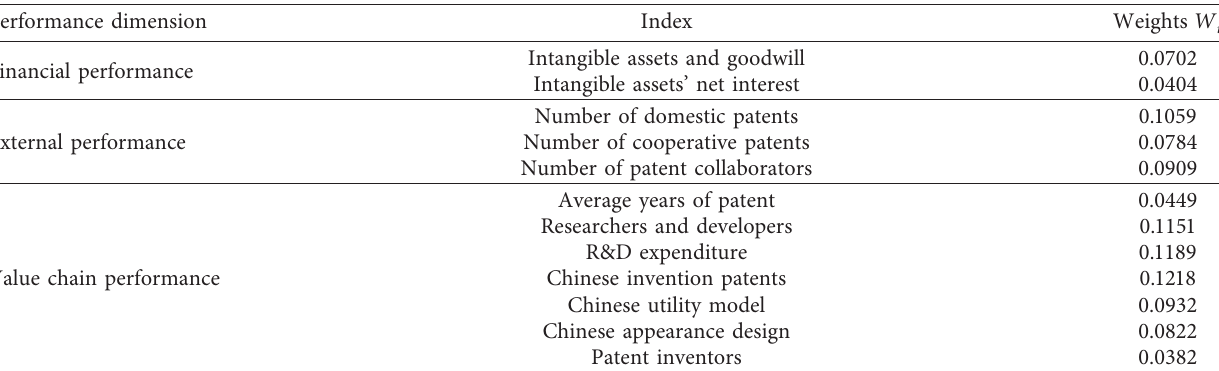
Table 3: Calculation results of index